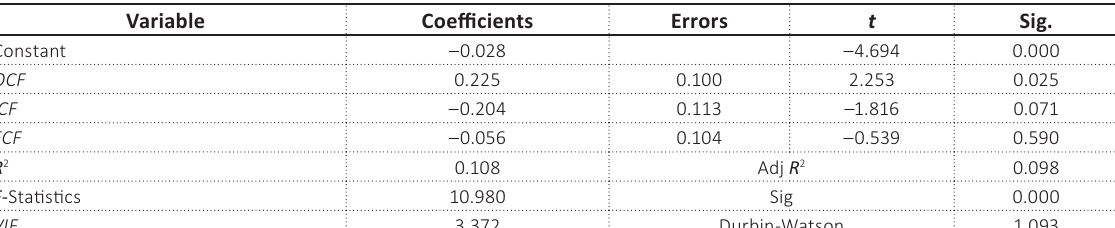
Table 6. OLS regression results (long operating cycle companies)